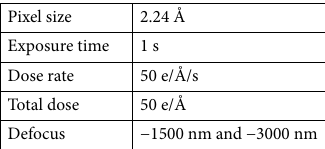
Table 2. Cryo-TEM imaging